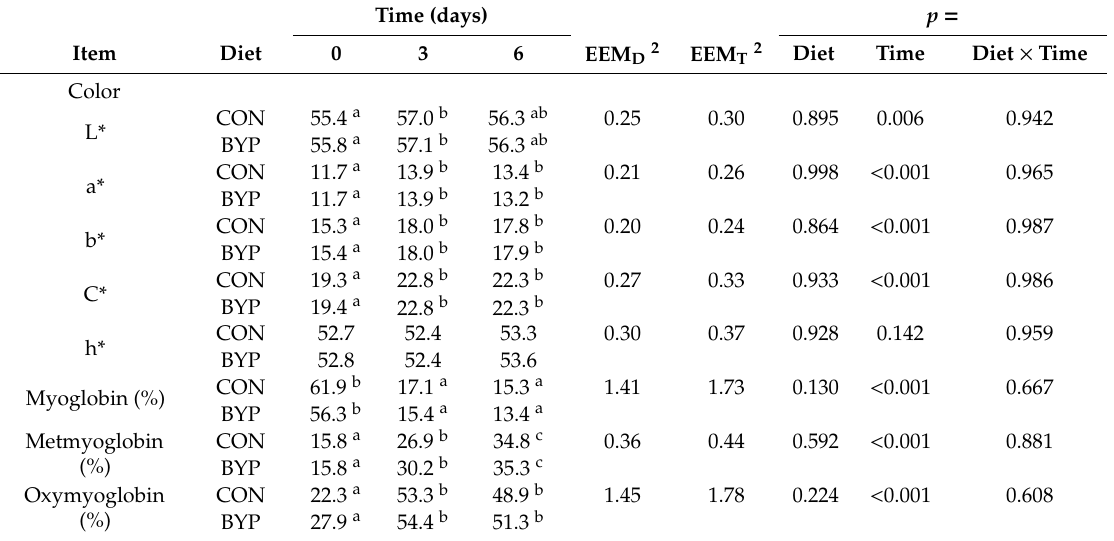
Table 3. Evolution of color parameters of the longissimus dorsi of light lambs fed either a high-cereal concentrate (CON) or a concentrate including by-products (BYP) during storage at 2 ◦ C 1 .